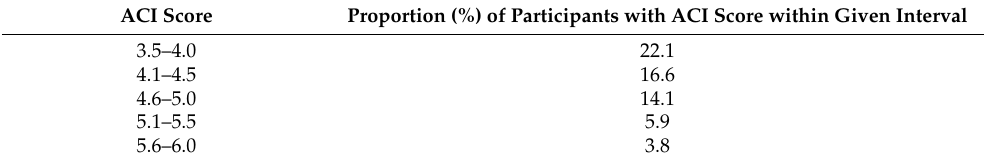
Figure 1. Distribution of ACI scores, by intervals. Red line: the mean of ACI score was 3.7; Orange line: the median was 3.8; Blue lines mark the ACI score intervals are shown in Table 2. Table 2. Distribution of ACI scores, by intervals.